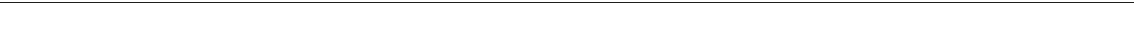
Fig. 2 Homology-directed AAVS1 targeting using standard and in trans paired nicking strategies. a Diagram of standard and in trans paired nicking (Nick 2 ) procedures. The former involve DSB formation only at the target sequence; the latter comprise SSB formation at target plus donor sequences. pDonor S1 and pDonor S1.TS have their transgenes framed by sequences homologous to AAVS1 . pDonor S1.TS differs from pDonor S1 in that it has the gRNA S1 target site (TS) bracketing its EGFP-encoding targeting module. Cas9:gRNA S1 and Cas9 D10A :gRNA S1 are cleaving and nicking RGNs, respectively. Open and solid magenta arrowheads , position of the phosphodiester bond cleavage induced by Cas9 ’ s RuvC and HNH nuclease domains, respectively. Solid arrowhead , position of the SSB induced by Cas9 D10A . Amplicons diagnostic for telomere-sided and centromere-sided transgenic- AAVS1 junctions (jT and jC, respectively), are depicted. b Quanti fi cation of stably transfected cells. Flow cytometry of long-term HeLa and 293 T cell cultures initially transfected with the indicated plasmids. The bars correspond to mean ± s.d. of six biological replicates from two independent experiments (three biological replicates per